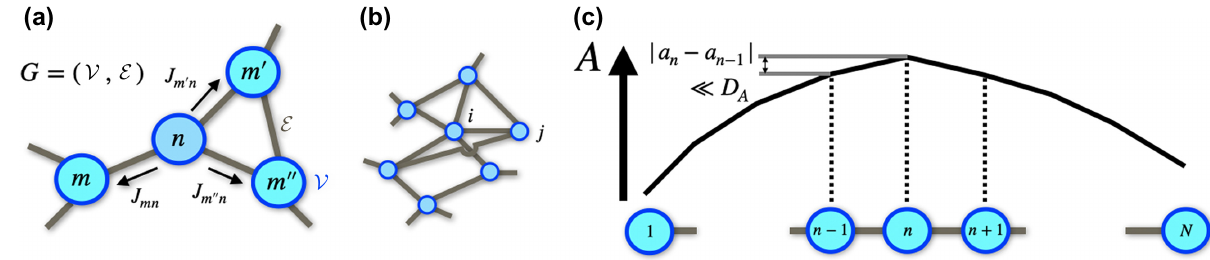
FIG. 3. (a) Schematic illustration of a graph composed of vertices V and edges E . Each of the vertices satisfies the continuity equation as shown in Eq. (6). (b) An example of a graph, where each vertex indicates the microscopic states i , j , . . . such as the basis of the Hilbert space. (c) Another example of a graph, which is one dimensional and has edges E = { ( 1, 2 ) , . . . , ( n , n + 1 ) , . . . , ( N − 1, N ) } . We are interested in a situation where the observable A is smooth on a graph, i.e., | a n − a m | with ( n , m ) ∈ E are much smaller than the maximum range of A , denoted by D A